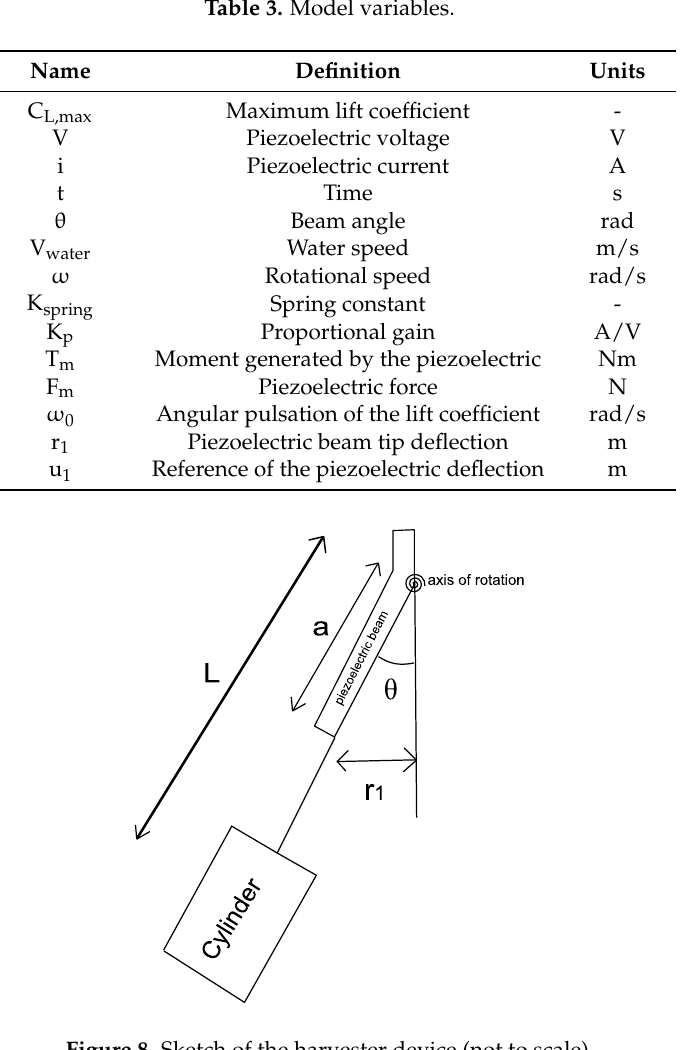
Table 3. Model variables.